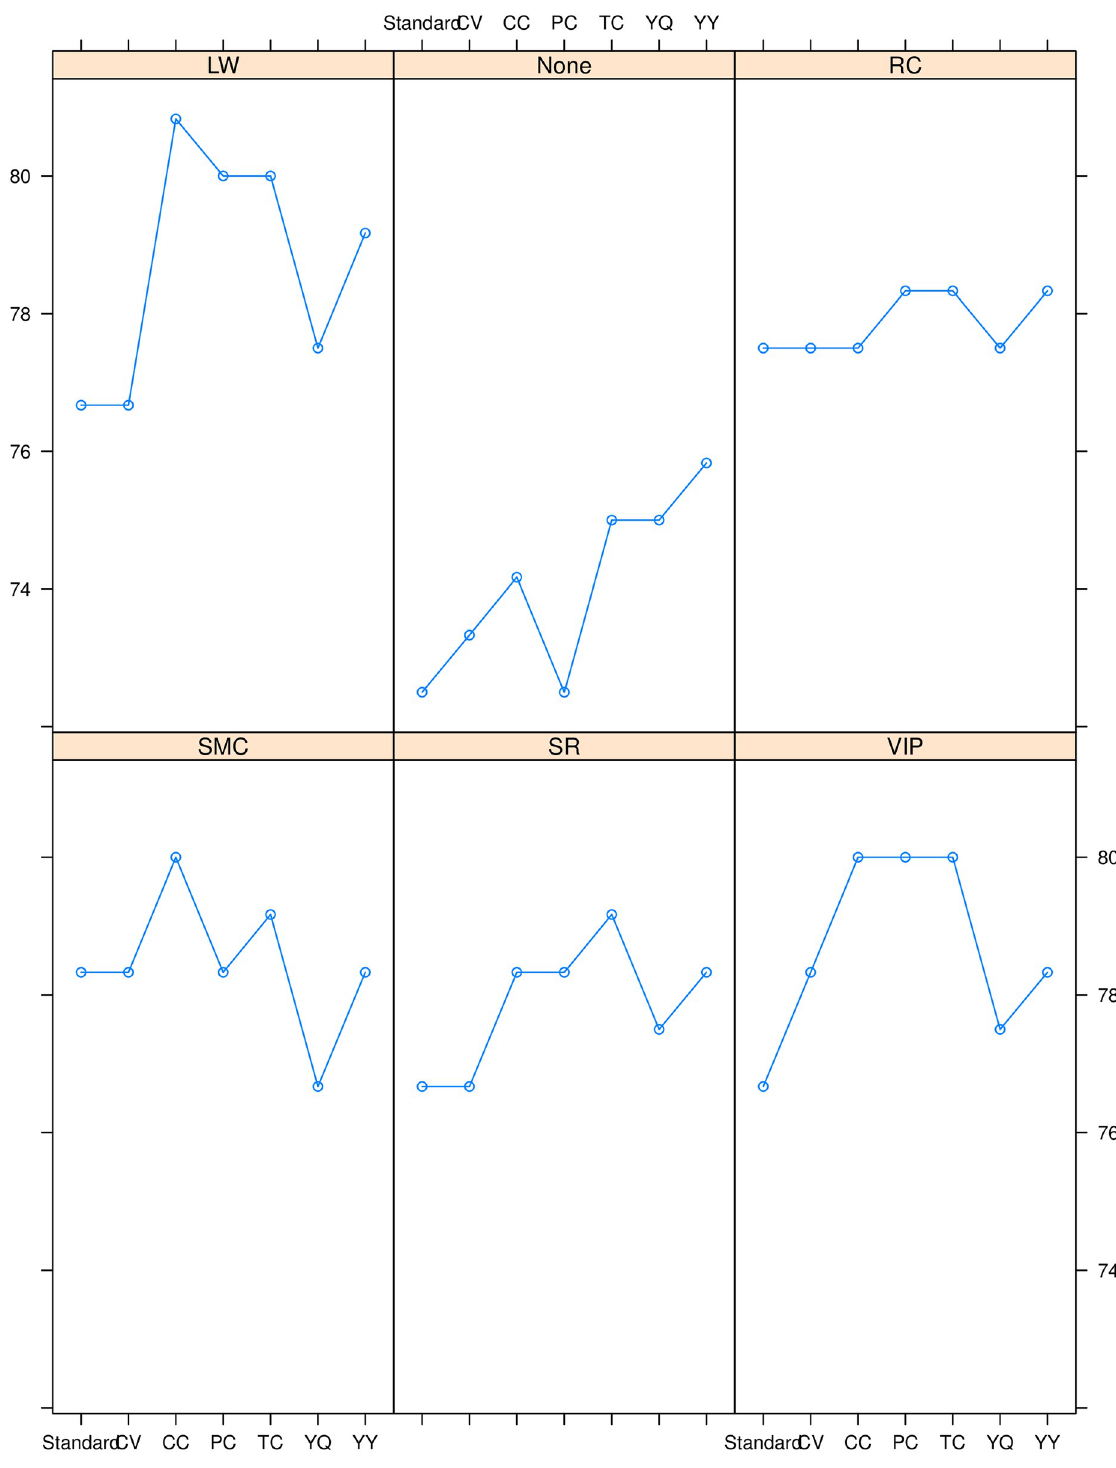
Fig 3. The validation accuracy of PLS methods including, Cramer’s V PLS (CV-PLS), Phi coefficient PLS (PC-PLS), Tschuprow’s T coefficient PLS (TC-PLS), Pearson’s contingency coefficient PLS (CC-PLS), Yule’s Q PLS (YQ-PLS) and Yule’s Y PLS (YY-PLS) models against the filter subset selection methods including LW, RC, VIP, SR and SMC by using lattice plot is presented in the upper panel, while the calibration accuracy is presented in the lower panel.